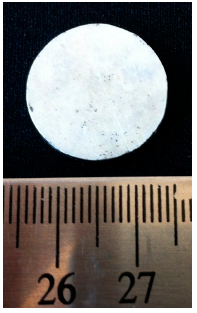
Figure 16. Image of the 2 cm-diameter white pellet.